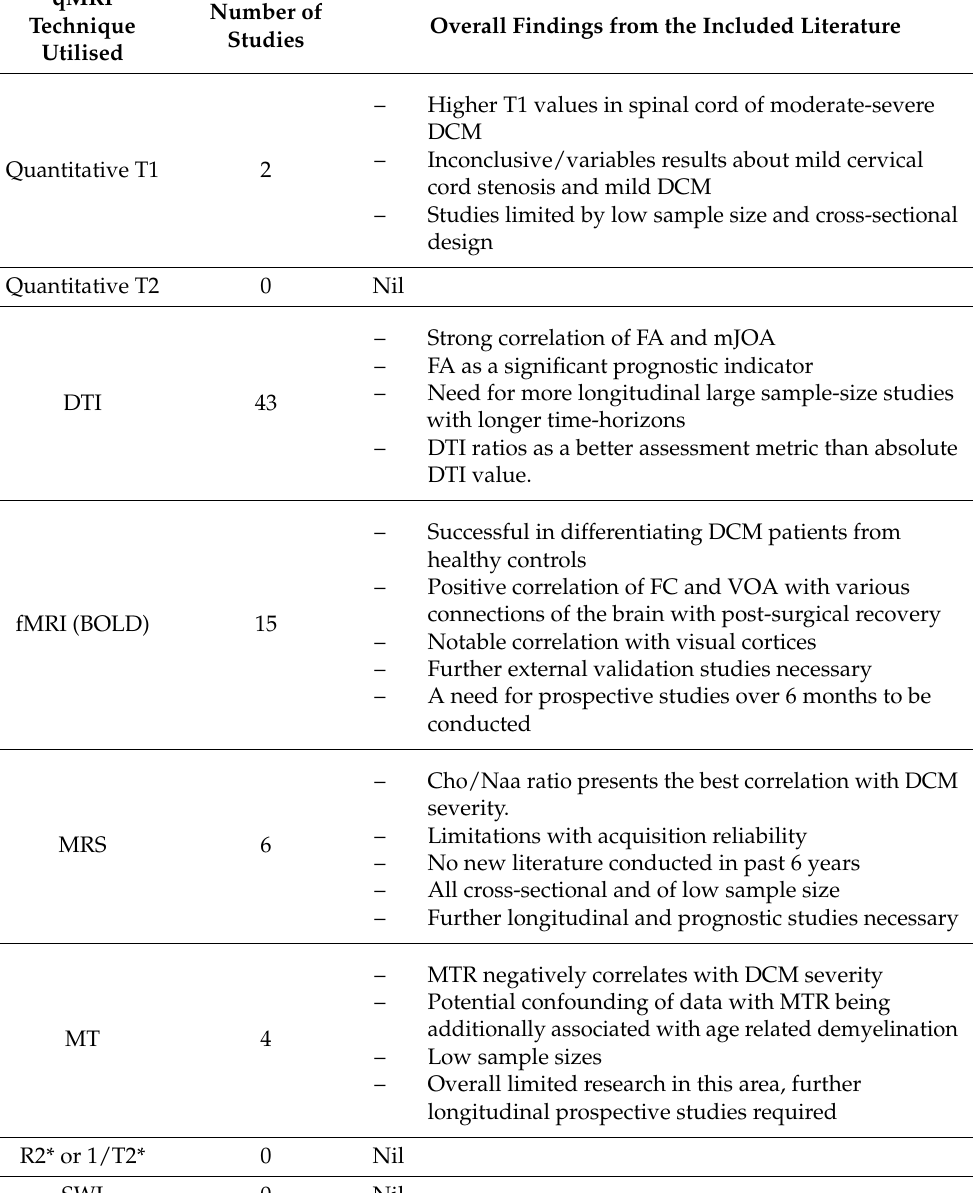
Table 4. Summary of qMRI techniques utilised in the 68 included articles of this study (N.B. some studies investigated a multiplicity of qMRI techniques). Refer to Appendix C (Table A8) for included articles